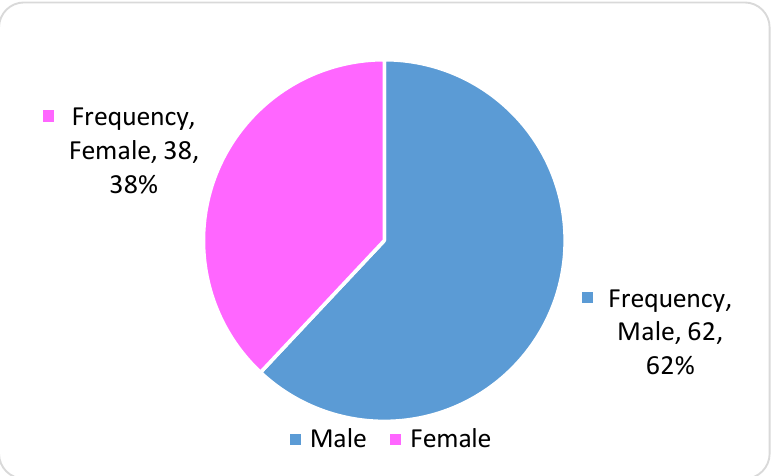
Figure 4: Sex distribution in 100 patients with COVID-19.